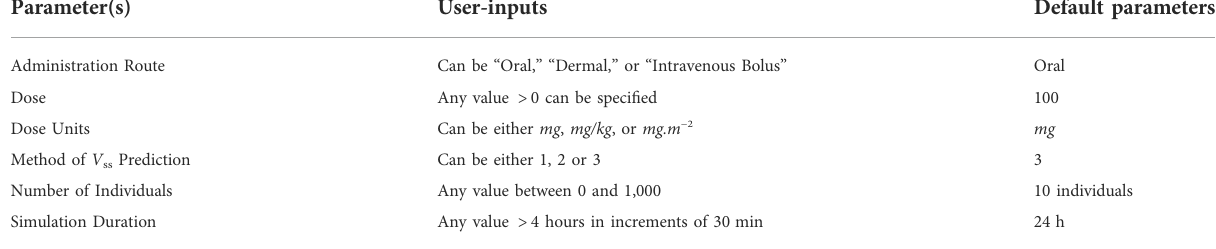
TABLE 3 The user-modi fi able parameters and their defaults. Defaults are applied when users do not specify values for these